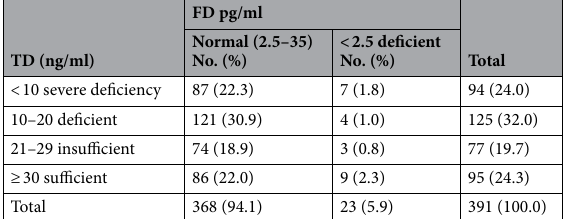
Table 11. Comparison between Total 25-OHD versus Free 25-OHD. P-value =